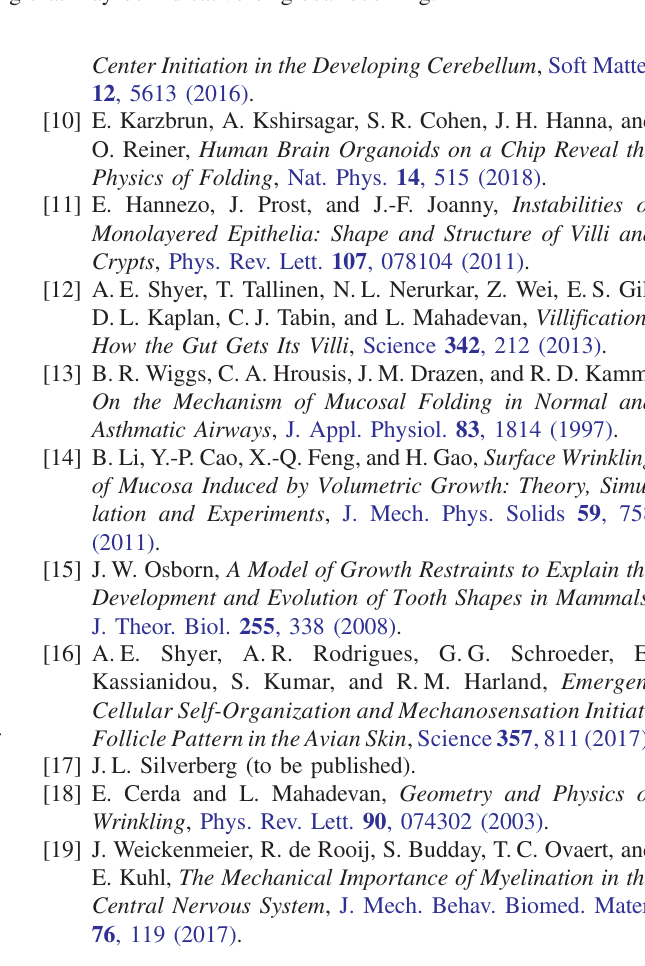
(2017).FIG. 7. Additional bilayer wrinkling simulations, similar to those shown in Fig. 1, but with different geometries and modulus ratios. Top row: maximum in-plane principal stress normalized to half of the substrate ’ s shear modulus. Insets show the sign of the stress-tensor component in the direction of the surface normal, with yellow indicating positive values (tension) and purple indicating negative values (compression). Bottom row: substrate height (blue) and film thickness (red), normalized to their average values. The rightmost case with a relatively thick film shows a rotational symmetry breaking that may be indicative of global